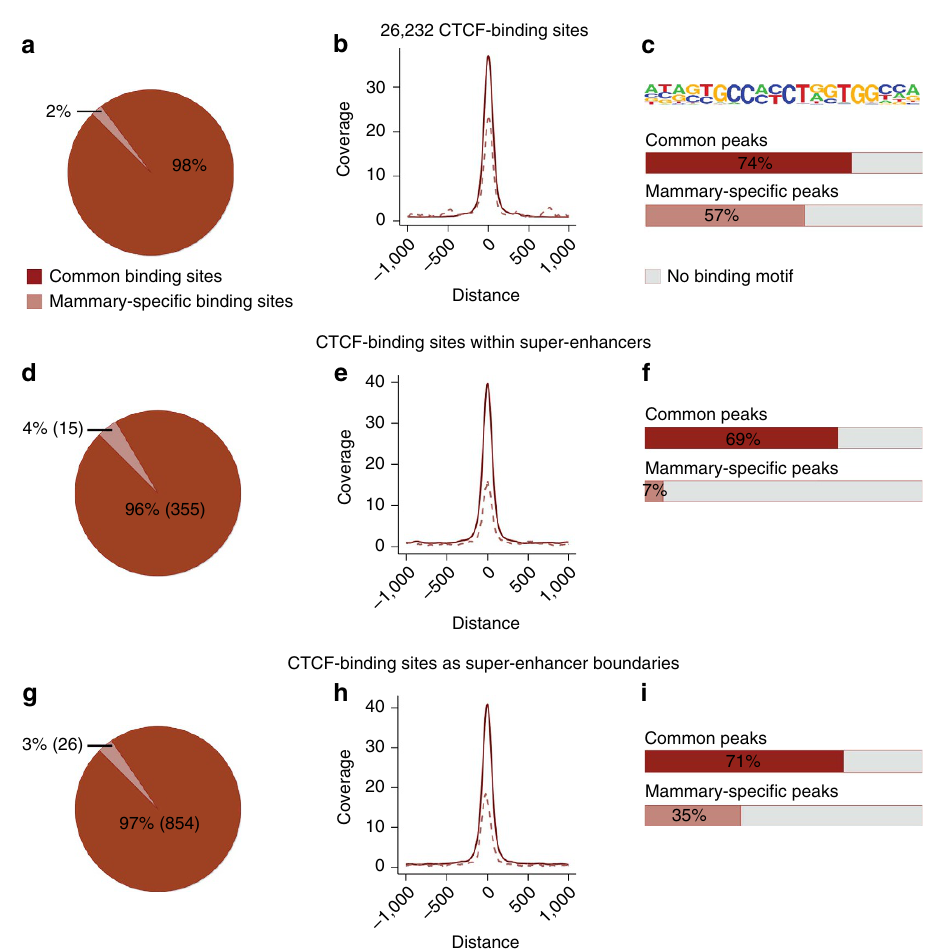
Figure 1 | Global analysis of CTCF-binding sites. A total of 26,232 CTCF-binding sites were identified by ChIP-seq of mammary tissue from lactating mice, by peak calling and overlapping three CTCF ChIP-seq samples ( a ) Ninety-eight per cent (25,644) of the sites were shared between mammary tissue, adipose tissue, cerebellum, heart, kidney and Th17 cells (GSE29218, GSE40918, GSE74189, GSE74826). Out of those, 65% (16,733) have been identified in all tissues and 35% (8,911) in distinct subsets. Two per cent (588) of the sites appeared to be mammary-specific. ( b ) Read coverage of CTCF-binding sites shared between tissues (height 37) was approximately 1.6 times higher than the mammary-specific ones (height 23). ( c ) The CCCTC motif was the highest ranked motif in both peak sets ( ± 200bp). Seventy-four per cent (19,057) of CTCF-binding sites shared between tissues had an underlying CCCTC-binding motif and 57% (337) of the mammary-specific binding sites had one. ( d ) A total of 370 CTCF-binding sites were detected within the 440 mammary super- enhancers. Ninety-six per cent (355) of them were shared CTCF-binding sites and 4% (15) were mammary-specific. ( e ) The read coverage of CTCF- binding sites shared between tissues (height 40) was approximately 2.5 times higher than those of mammary-specific ones (height 16). ( f ) Sixty-nine per cent (246) of the shared CTCF-binding sites and one site (7%) of the mammary-specific ones had an underlying CTCF motif. ( g ) CTCF-binding sites associated with 440 mammary super-enhancer boundaries. Ninety-seven per cent (854) were shared between tissues and 3% (26) were mammary- specific. ( h ) Read coverage of CTCF-binding sites shared between tissues (height 41) was approximately two times higher than that of mammary-specific ones (height 19). ( i ) Seventy-one per cent (610) of shared CTCF-binding sites, and 35% (nine) of mammary-specific ones had an underlying CTCF